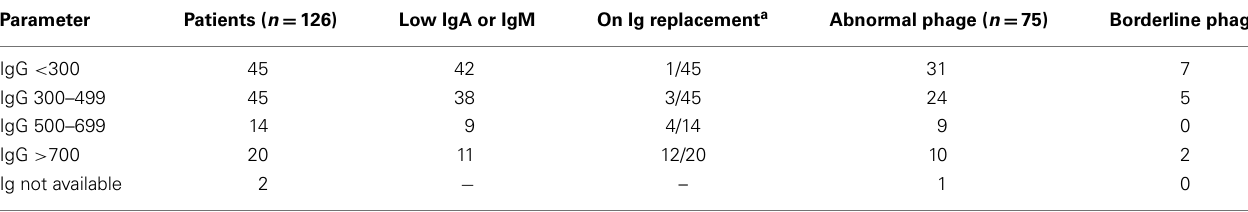
Table 2 | Serum immunoglobulin levels prior to immunization